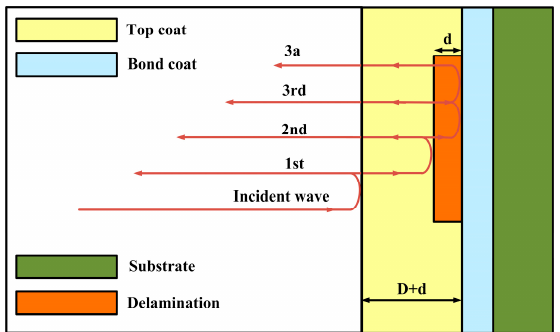
Figure 1. Schematic diagram of terahertz waves propagation path in the thermal barrier coatings with the interface delamination.